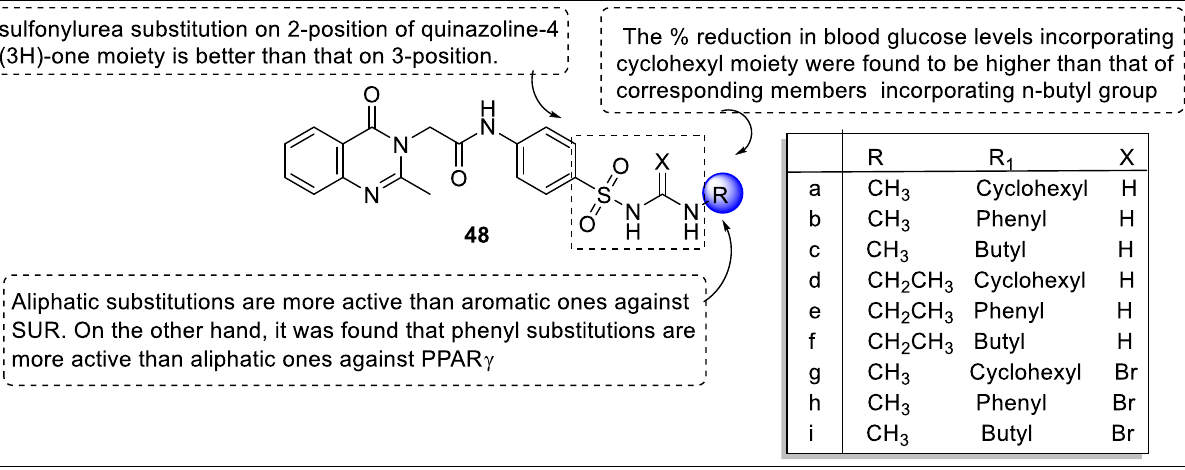
Figure 51. Structural activity relationship of quinazoline hybrids ( 47 ) as potent PPAR ligands.